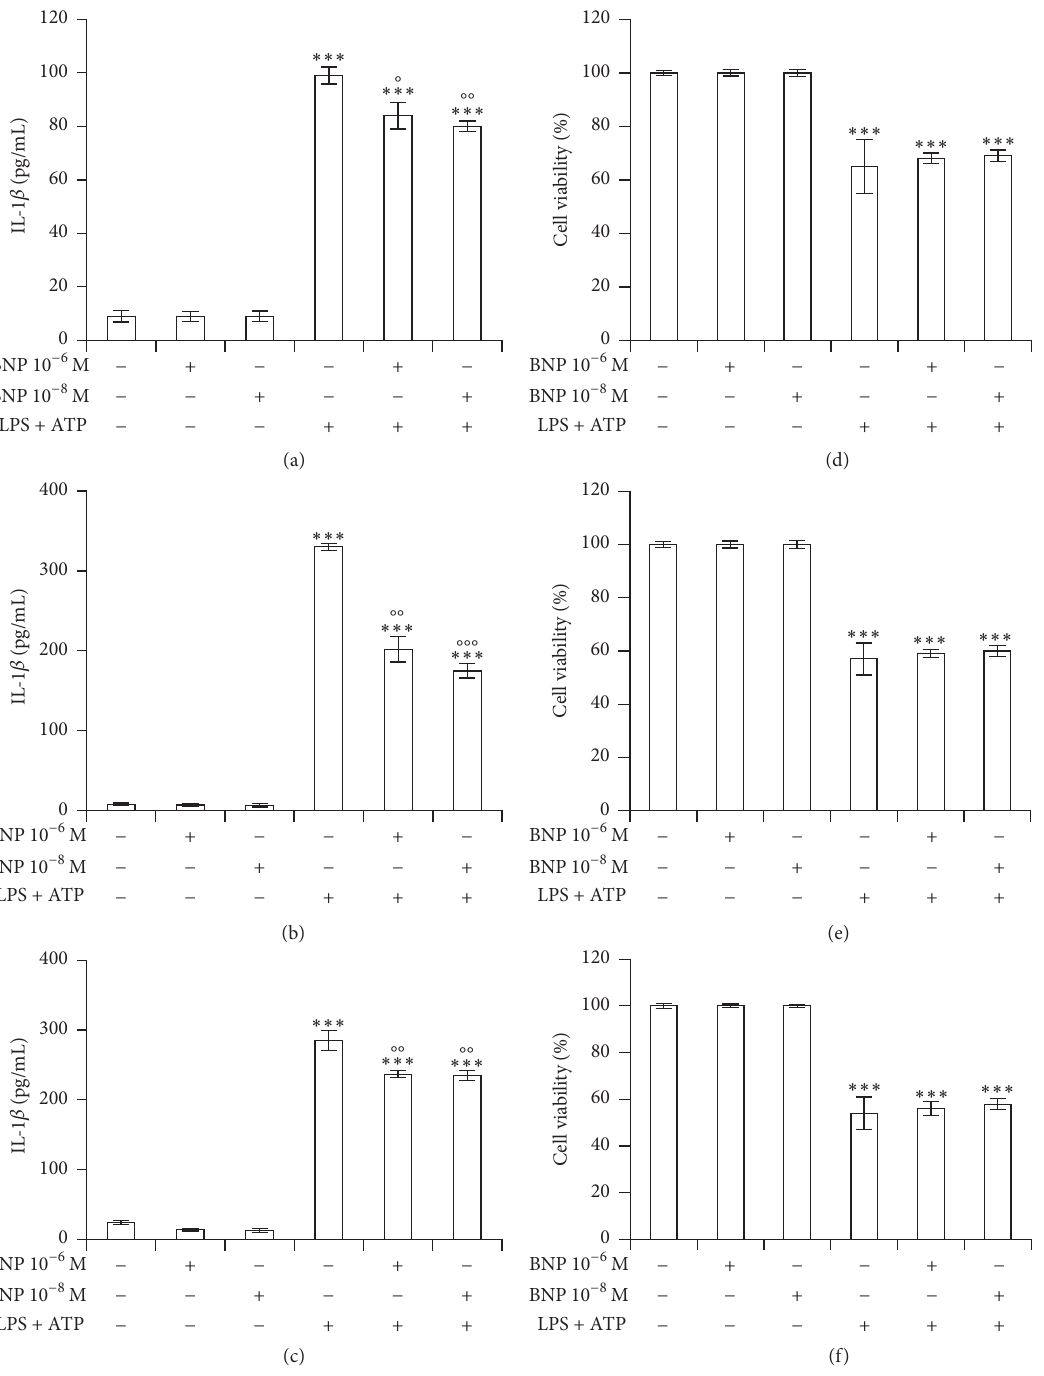
Figure 1: BNP decreases LPS/ATP-induced IL-1 𝛽 release in THP-1 cells. THP-1 cells were treated with 10 −6 and 10 −8 M BNP in absence or presence of 10 𝜇 g/mL LPS/5 mM ATP for 24 (a, d), 48 (b, e), and 72h (c, f). The supernatants were collected and IL-1 𝛽 release was measured by ELISA (a, b, c). Cell viability was assessed by trypan blue uptake assay (d, e, f). Histograms indicate means ± SD of three separate experiments each one tested in triplicate. ∗∗∗ 𝑃 < 0.001 versus untreated cells and ∘ 𝑃 < 0.05, ∘∘ 𝑃 < 0.01, and ∘∘∘ 𝑃 < 0.001 versus LPS/ATP treated cells.